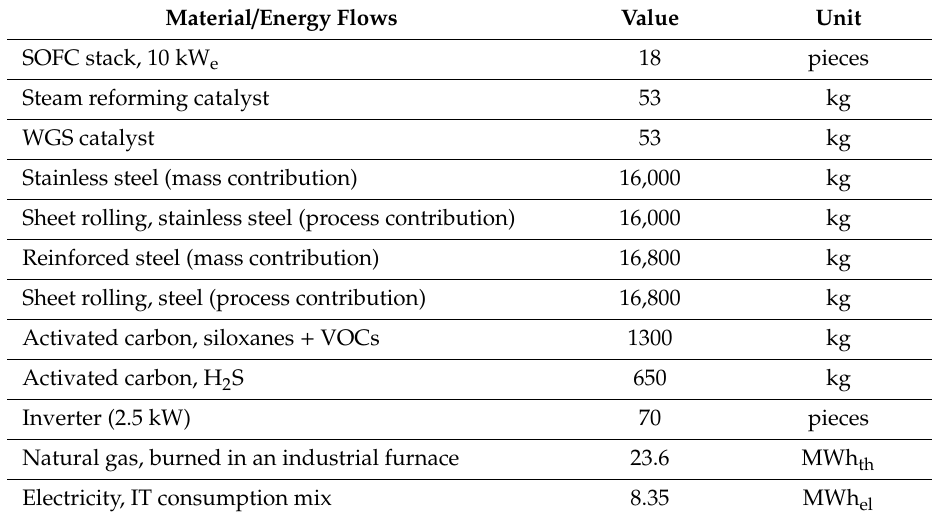
Table 5. Manufacture of the SOFC based CHP system. Reference flow: 1 SOFC CHP system, net power 174 kW el .